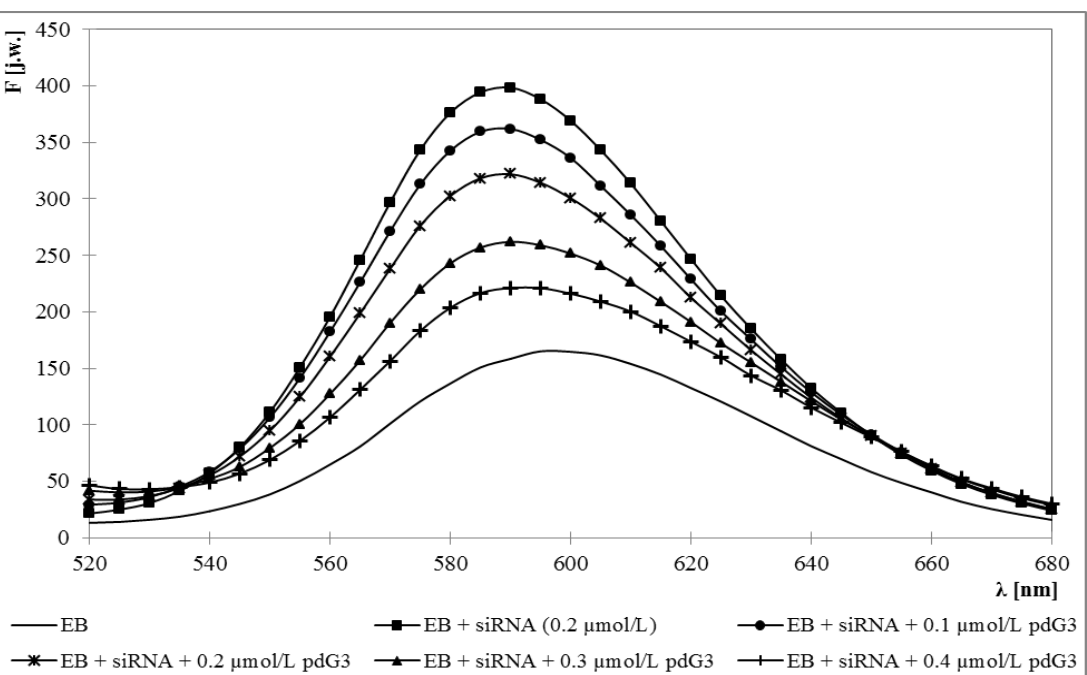
Figure 1. Fluorescence spectrum of ethidium bromide in the presence of siRNA and increasing concentrations of phosphorus dendrimer generation 3 (pdG3). [EB] = 5 μmol/L [siRNA] = 0.2